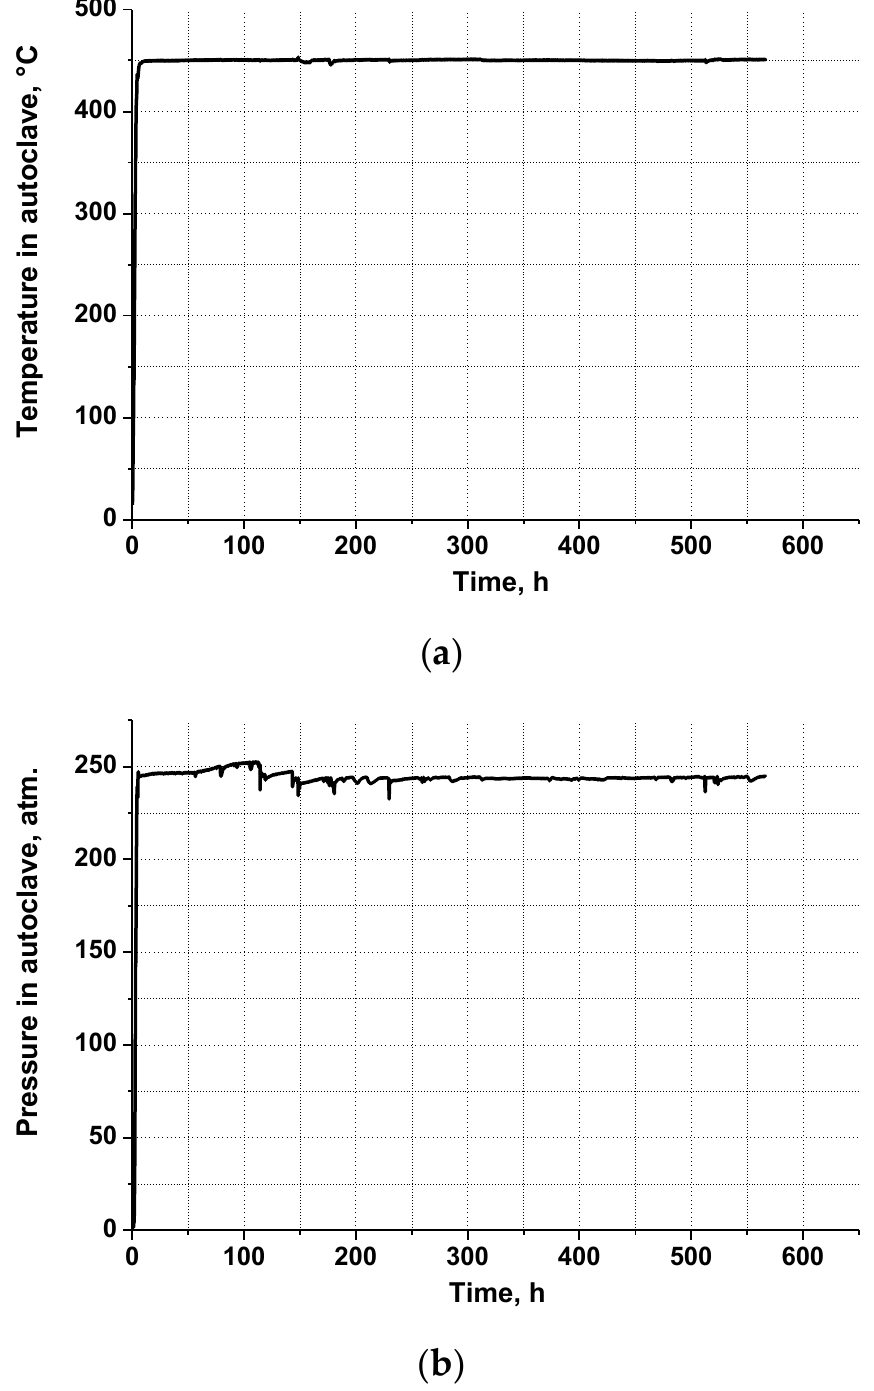
Figure 4. Dependences of temperature ( a ) and pressure ( b ) in the autoclave on time.